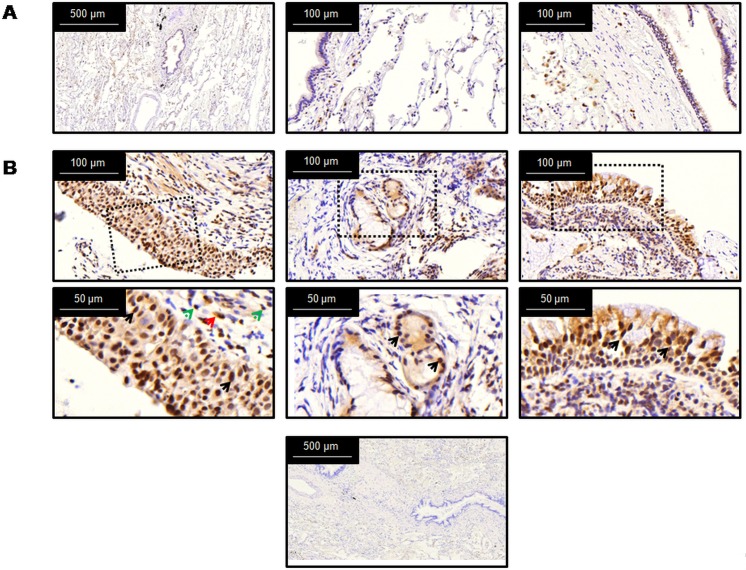
Immunohistochemical analysis showed that MAP3K19 expression appeared greater in COPD lung than normal human lung.(A) Normal human lung was stained with the anti-MAP3K19 polyclonal rabbit antibody, RabK19, shown in brown, and counterstained with hematoxylin. Expression of MAP3K19 is found in the ciliated bronchial epithelial cells, alveolar and interstitial macrophages, neutrophils, and some type II pneumocytes. (B) COPD biopsies are stained with anti-MAP3K19 (RabK19) antibody. In the left panels, the majority of the airway epithelial cells are stained (black arrows), and in the lamina propria the macrophages (red arrow) and lymphocytes (green arrows) are positive for MAP3K19 expression. The middle panels show the submucosal glands staining positive for MAP3K19. The right panels show the airway epithelial cells, particularly the nuclei, positive for MAP3K19 staining (black arrows), and variable staining of the inflammatory cells in the lamina propria. Images are shown from three COPD patients, and are representative of ten patients from whom biopsies were procured (diagnosed with COPD from 1–25 years). The lower panel is the negative control, an isotype control antibody. The patient demographics are listed in the S4 Table.